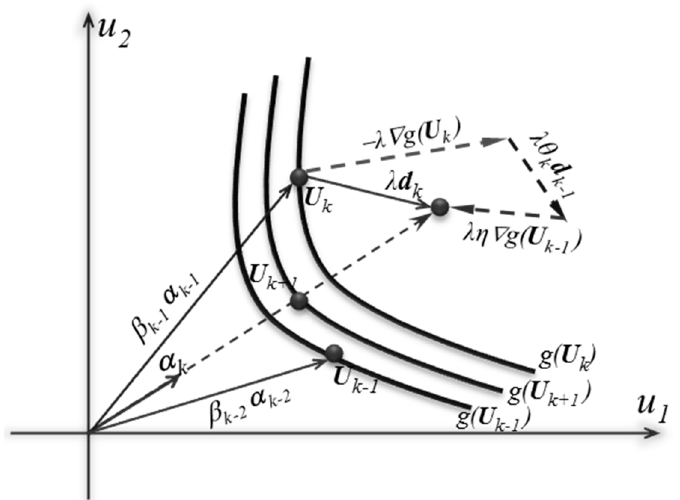
Figure 2. Illustration of the proposed framework process using the three-term conjugate map (TCM) algorithm, modified from [58].